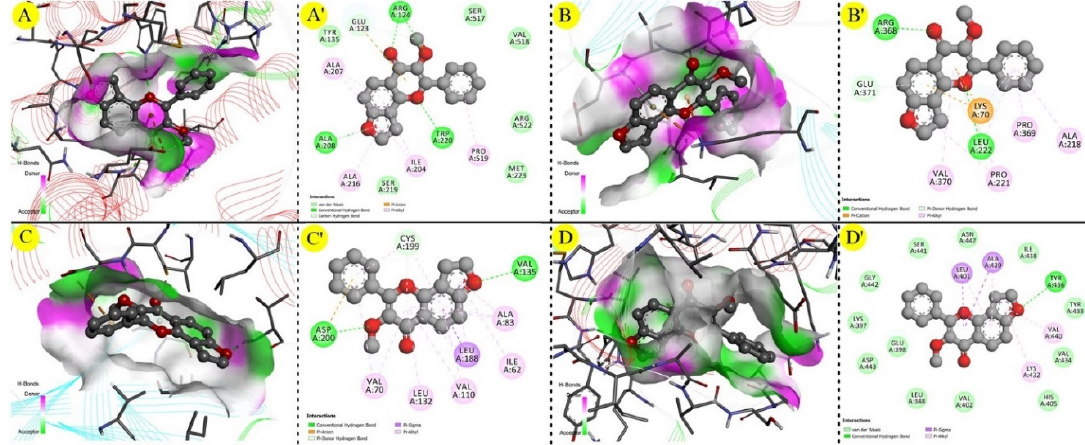
Figure 3. Molecular interactions of the natural karanjin against four putative drug targets of PD during study docking in 3D and 2D views (AutoDock); ( A & A ′ ) interaction against ACE (PBD ID: 1O86); ( B & B ′ ) interaction against BACE1 (PBD ID: 4DJU); ( C & C ′ ) interaction against GSK-3 (PDB ID: 1Q5K); and ( D & D ′ ) interaction against TACE (PDB ID: 2OI0), respectively. The 3D and 2D images were generated using the software Discovery Studio Visualizer. The grey spheres represent the ligand (karanjin), and arrows indicate the interaction of the karanjin with the amino residues present in the protein. The green colored line indicates the hydrogen bond interaction with the amino acid residues.